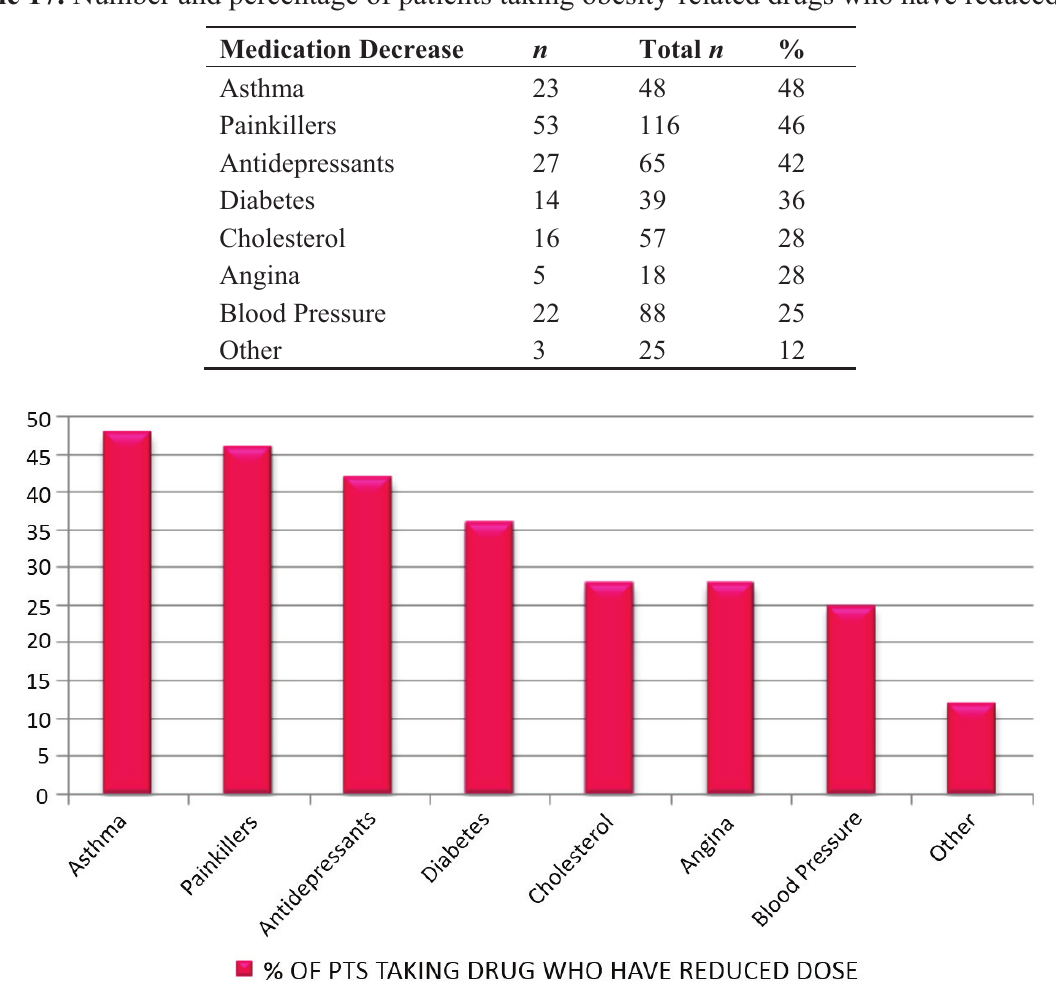
Table 17. Number and percentage of patients taking obesity-related drugs who have reduced dose.